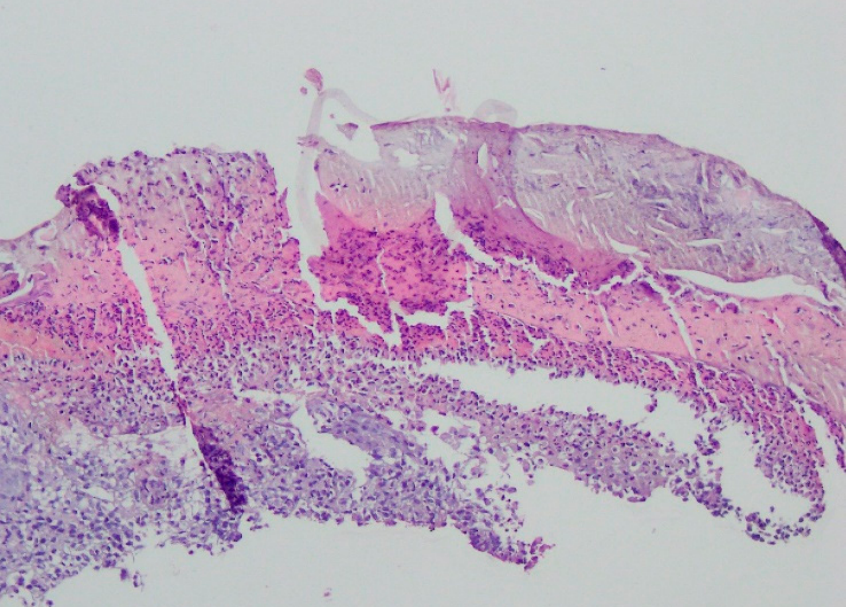
Figure 4. Enlarged swollen epidermis, abundantly infiltrated with neutrophils and covered by an exudative-neutrophilic scab. Under the epidermis, an abundant chronic inflammatory infiltration was found with a visible plasmocytic component. Clinical and pathological correlation for superfi- cial granulomatous pyoderma gangrenosum or another chronic pyoderma was recommended. The laboratory tests detected anti-nuclear antibodies (ANA) at a titre of